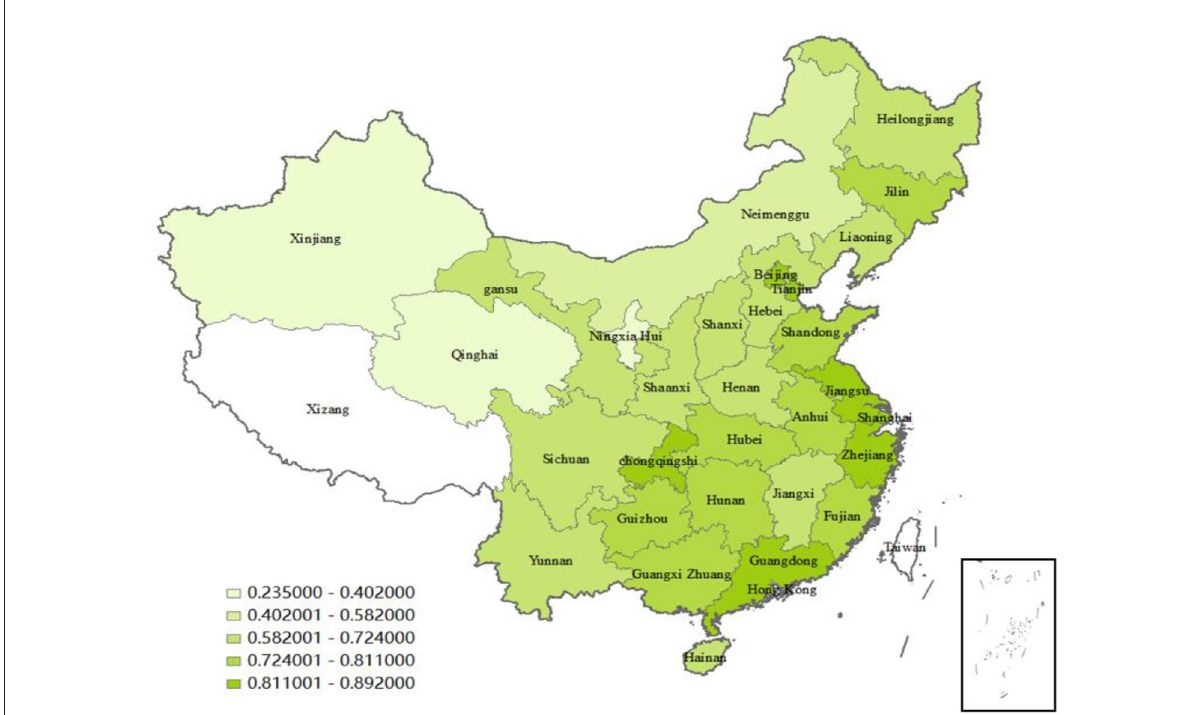
FIGURE2 Geographical distributions of the pharmaceutical industry’s GTFP in 30 provinces.